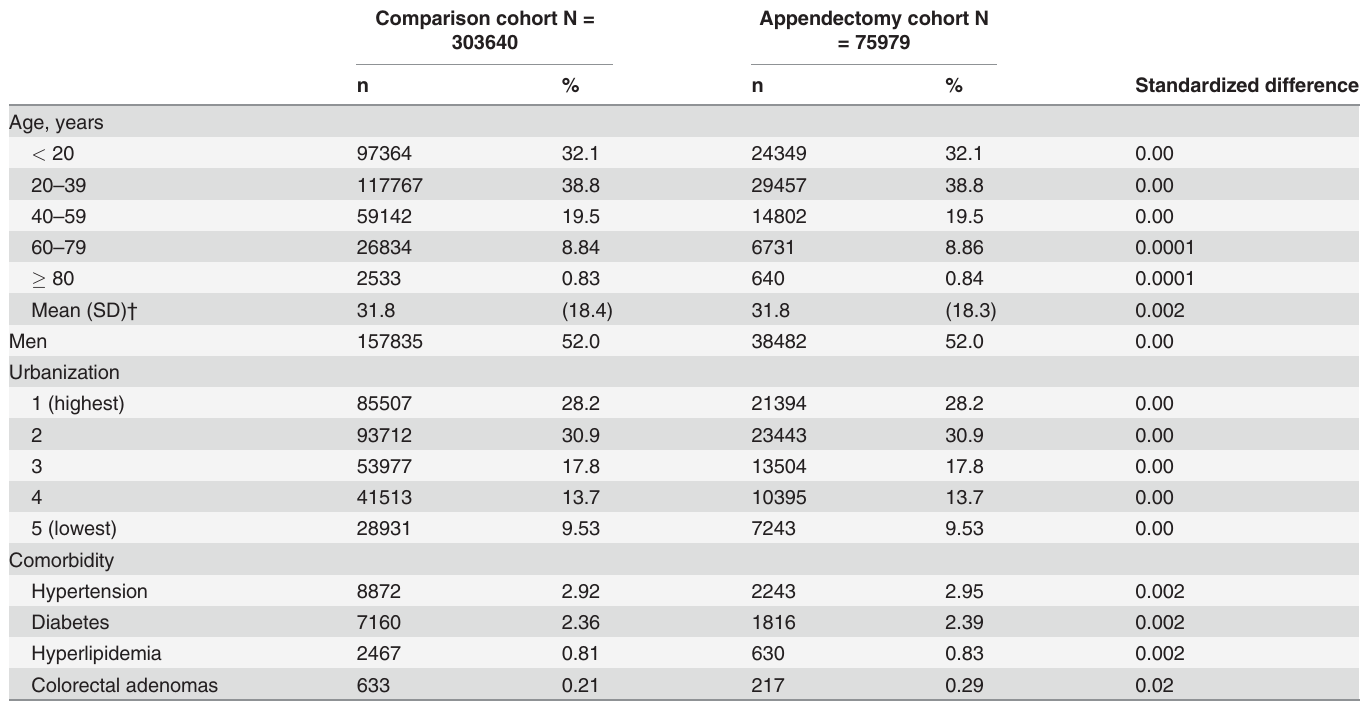
Table 1. Distribution of demographic characteristics and comorbidity between the appendectomy and comparison cohorts.